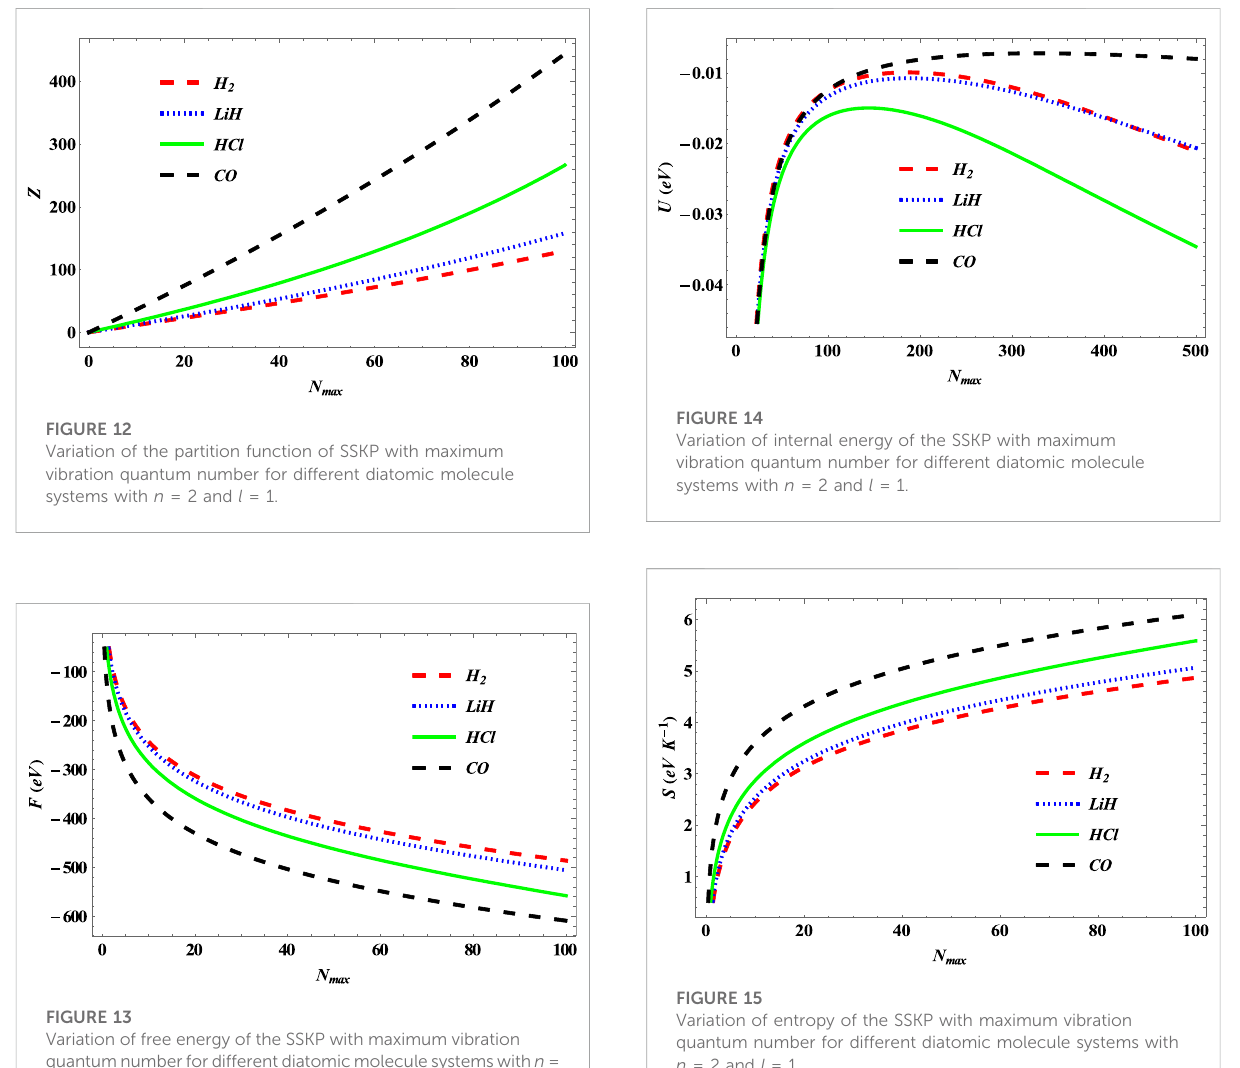
FIGURE 15 Variation of entropy of the SSKP with maximum vibration quantum number for different diatomic molecule systems with n = 2 and l = 1.